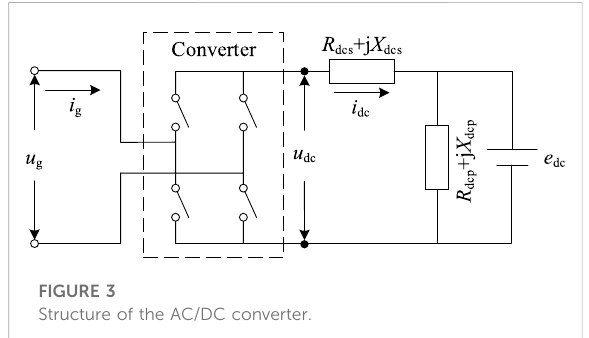
FIGURE 3 Structure of the AC/DC